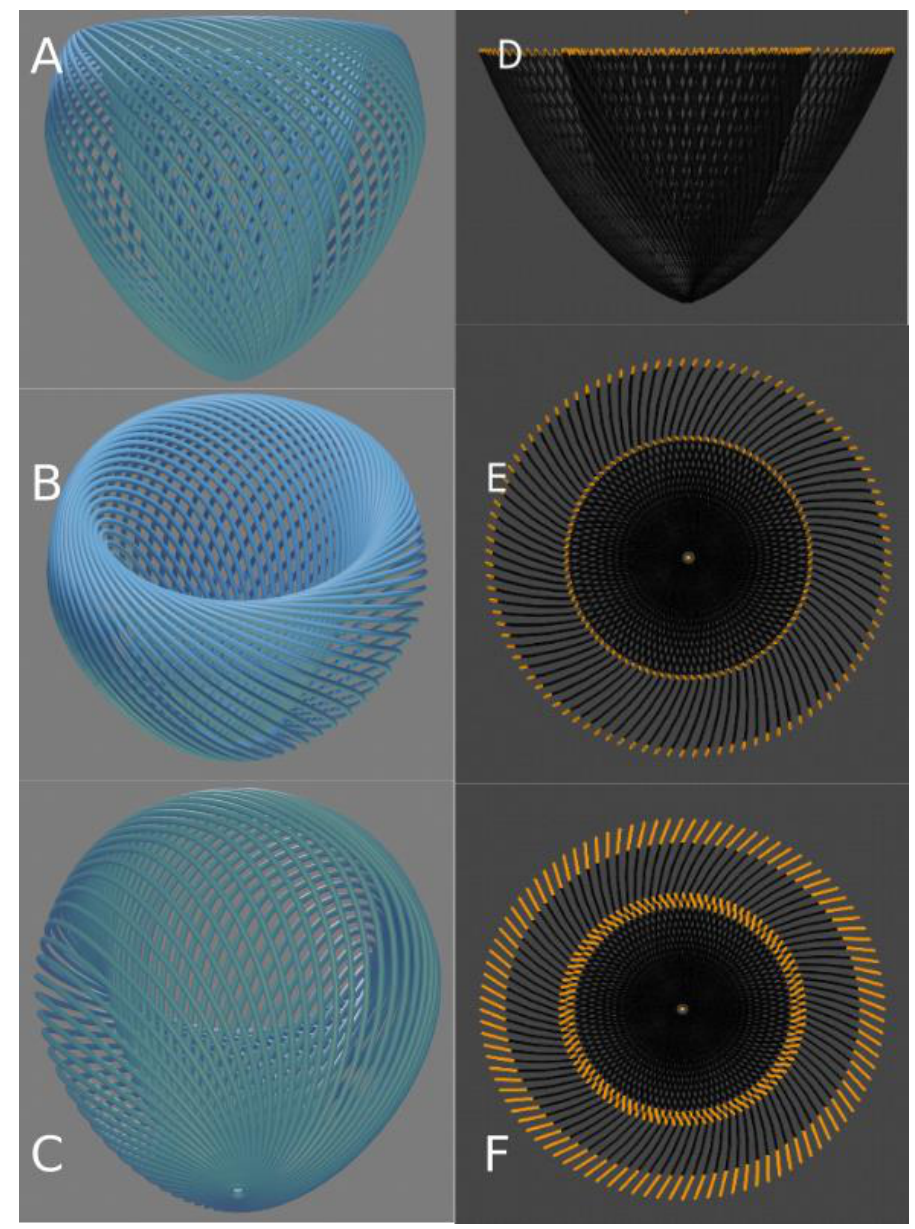
Figure 6. 3D model of a single torus, shaped to the compact myocardium of the left ventricle. ( A ) Side view of the torus regularly covered with fifty geodesics (nested tori inside are not displayed). On this torus, the external part represents the sub-endocardial region and the internal part, seen by transparency, represents the interface between the compact myocardium and the trabeculations. The torus aperture is wide in the basal part of the ventricle and becomes almost closed at the apex. ( B ) Three-quarter view from above of the same sketch to visualise the continuity of the geodesics from the inner and the outer part of the torus at the basal level. At this basal level, the mitral and aortic valves would reside. ( C ) Three-quarter view from below to visualise the continuity of the geodesics at the apical level. One can observe the geodesics invaginating at the apex from the outer surface of the torus to its inner surface. ( D ) Side view of an apical section. A hundred geodesics cut are coloured in orange. ( E ) Top view of the same section as in ( D ) with minimal thickness. ( F ) Same as in ( E ) with increased thickness. The segments, viewed from the top, constitute two coronas. The external corona is with a clockwise orientation and the internal one with an anticlockwise orientation. This has been described as a double spiral